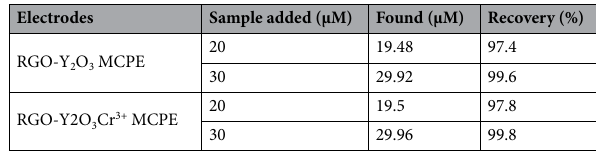
Table 3. Detection of DA in the real sample (n =